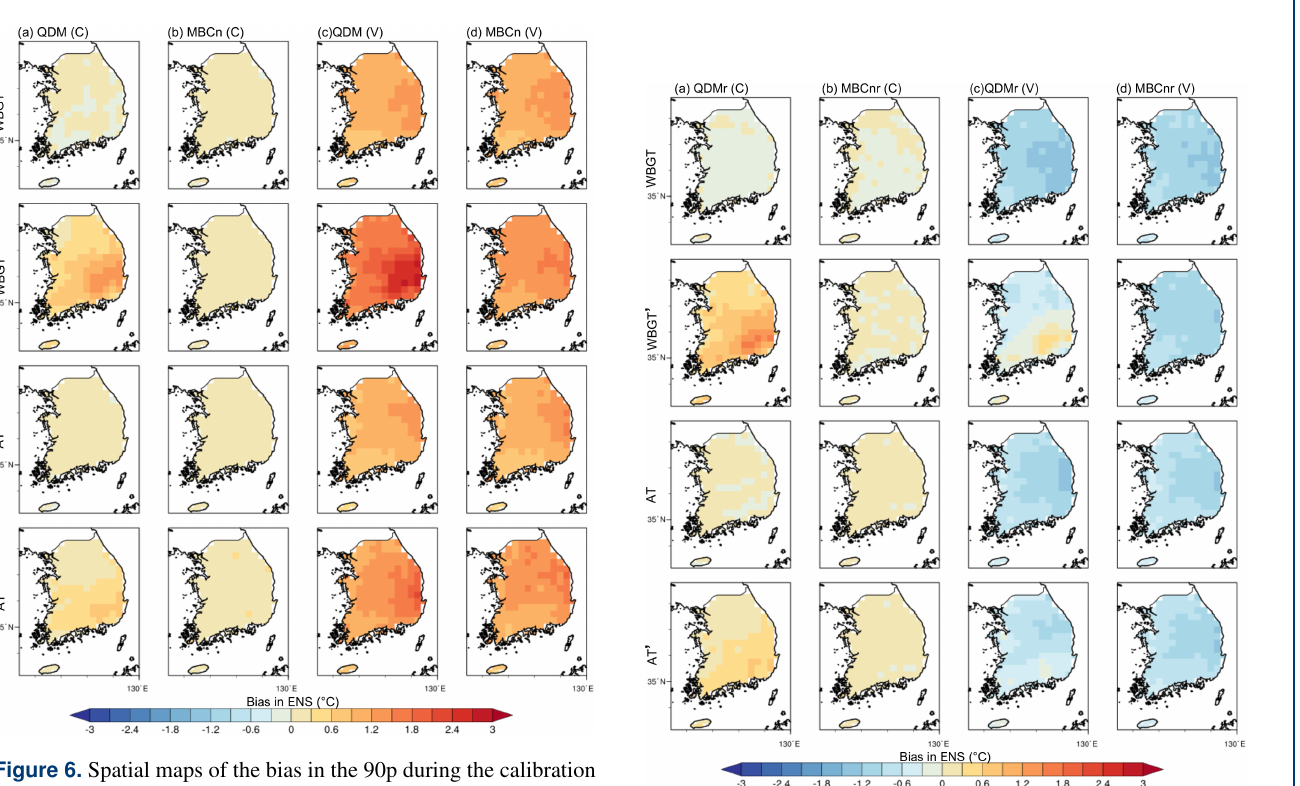
Figure 7. Same as Fig. 6 but for the reverse